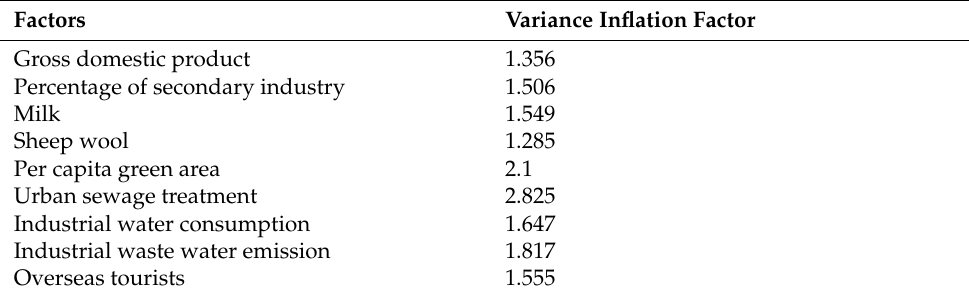
Table 2. Collinearity diagnostics of the independent variables.